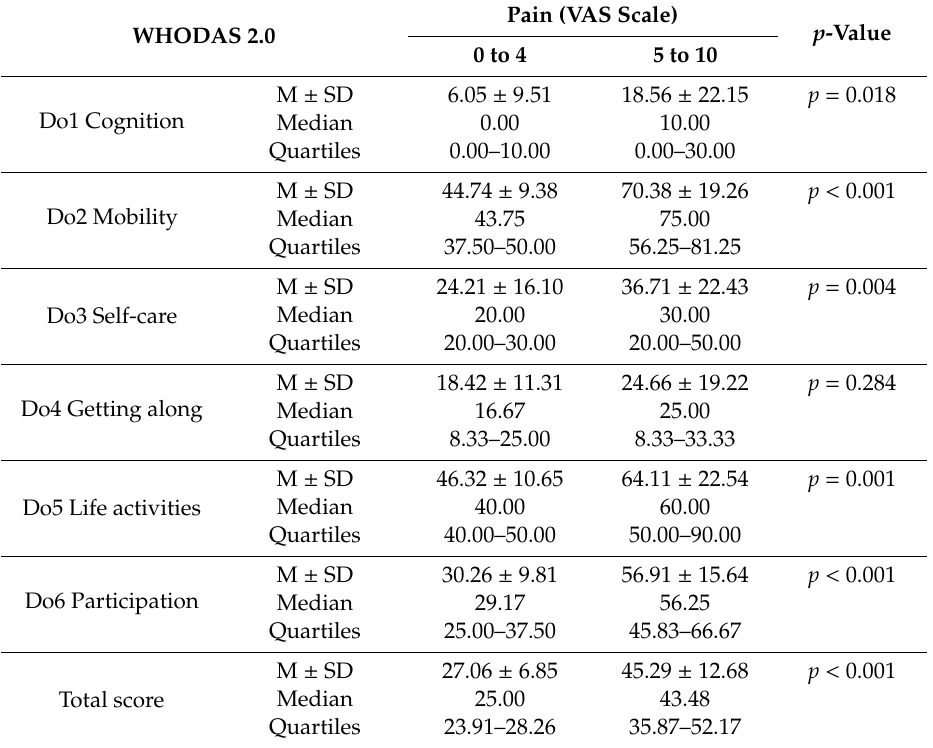
Table 5. Known group validity of the 36-item WHODAS 2.0.